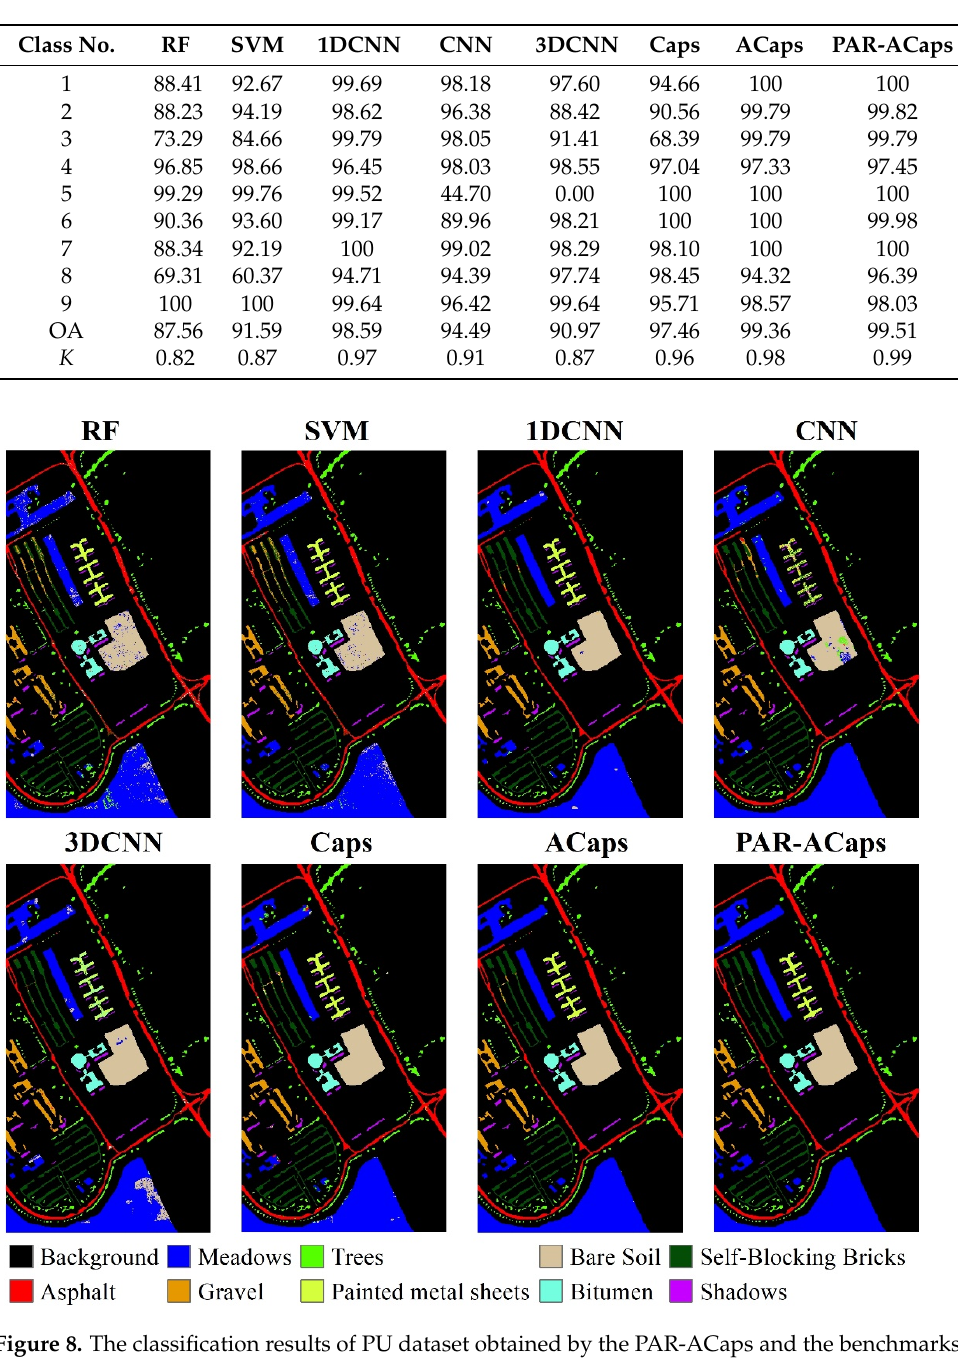
Table 3. The overall accuracy (%), per-class accuracy (%), and the Kappa coefficients ( K ) between the PAR-ACaps and other classification methods in terms of classification accuracy with PU dataset; class names are in Table 1.